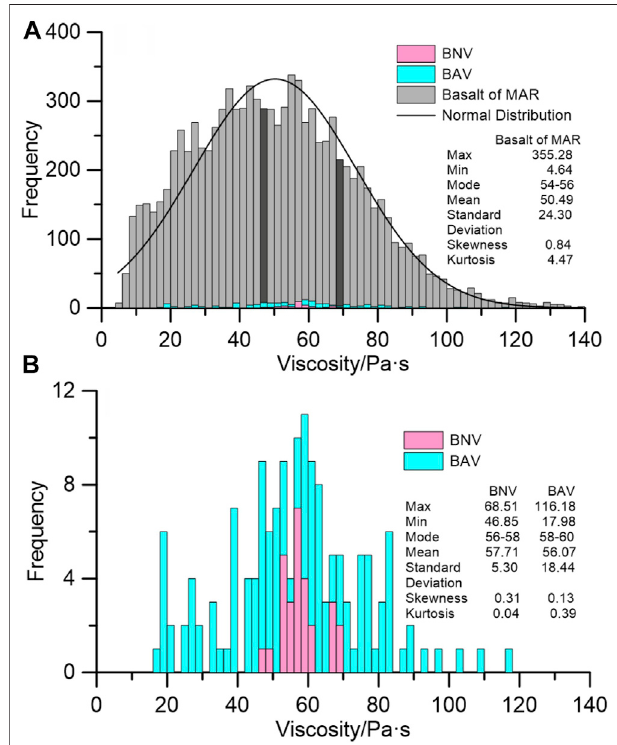
FIGURE 10 | (A) Frequency histograms of BNV, BAV, and MAR basalt samples. The darker grayscale shows the range of BNV. The statistical parameters on the right were computed for MAR basalt. (B) Frequency histograms of BNV and BAV.